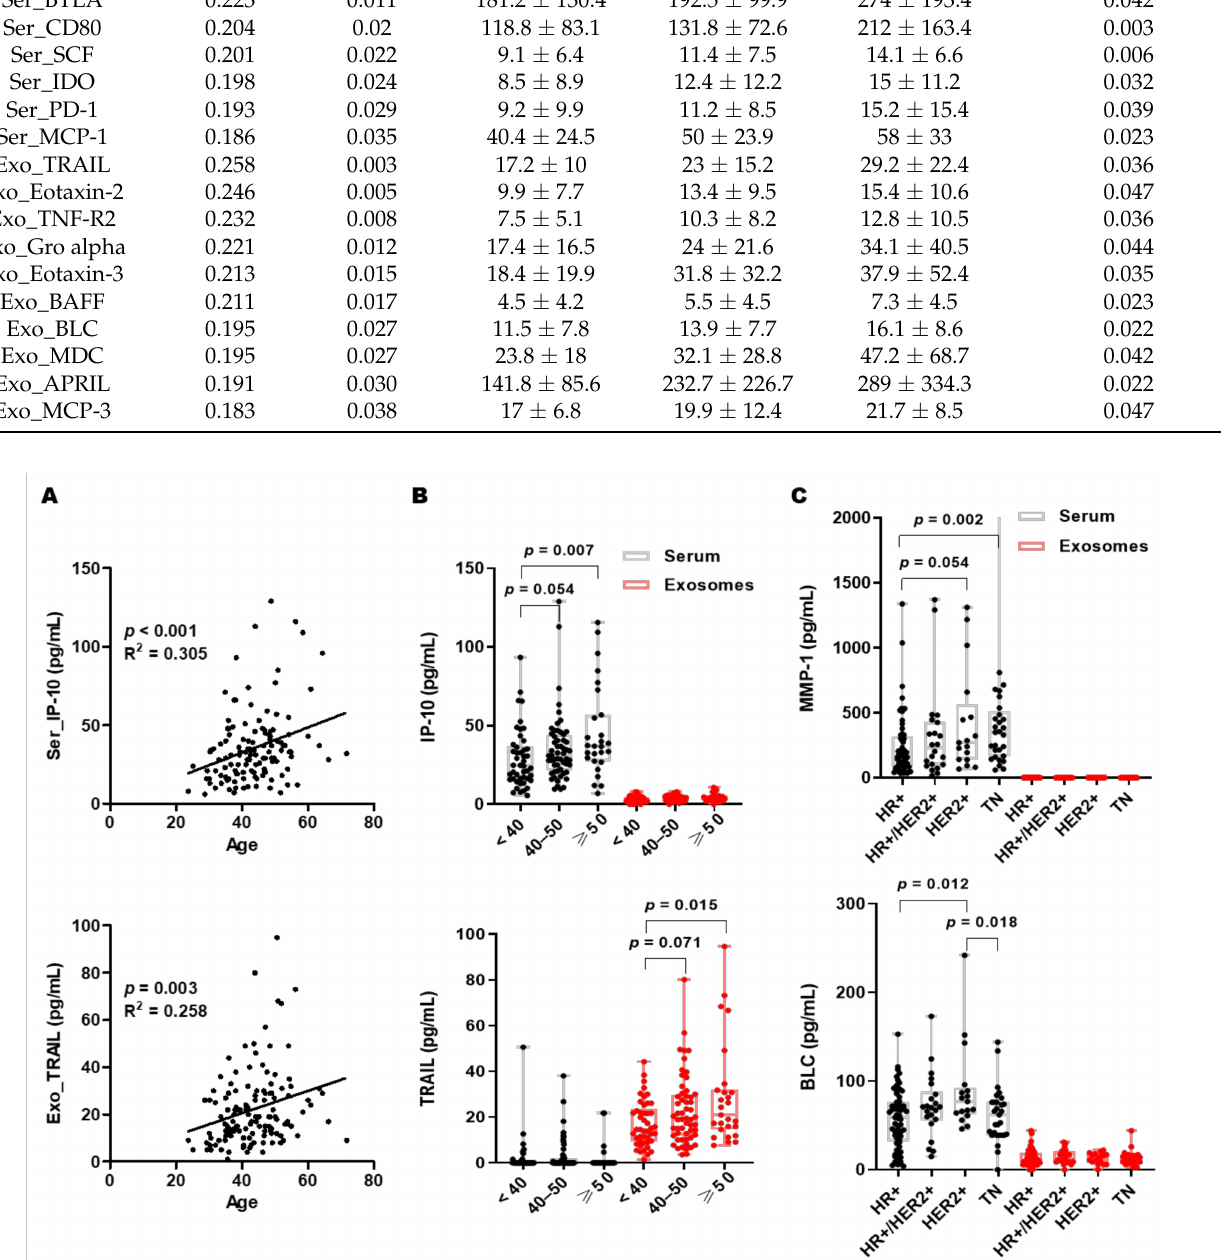
Figure 3. Biomarker expression levels according to age and subtype. ( A ) Correlation plots of age and biomarker level. Boxplots showing the distribution of biomarker levels according to age ( B ) and subtype ( C